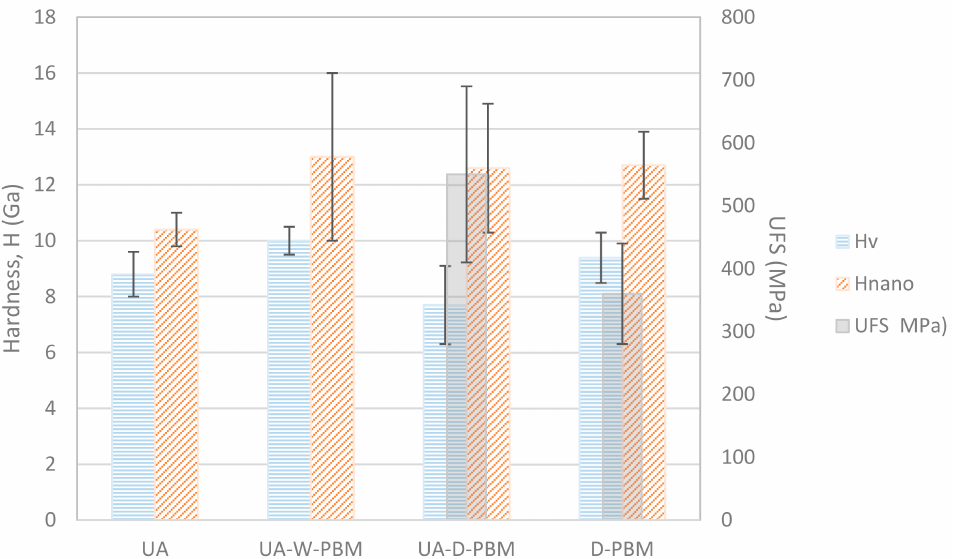
Figure 3. Vickers and nano-indentation hardness values (averaged for in i.p. -in plane- and c.s. –cross section- orientations) and ultimate flexure strength of the composites processed by the different